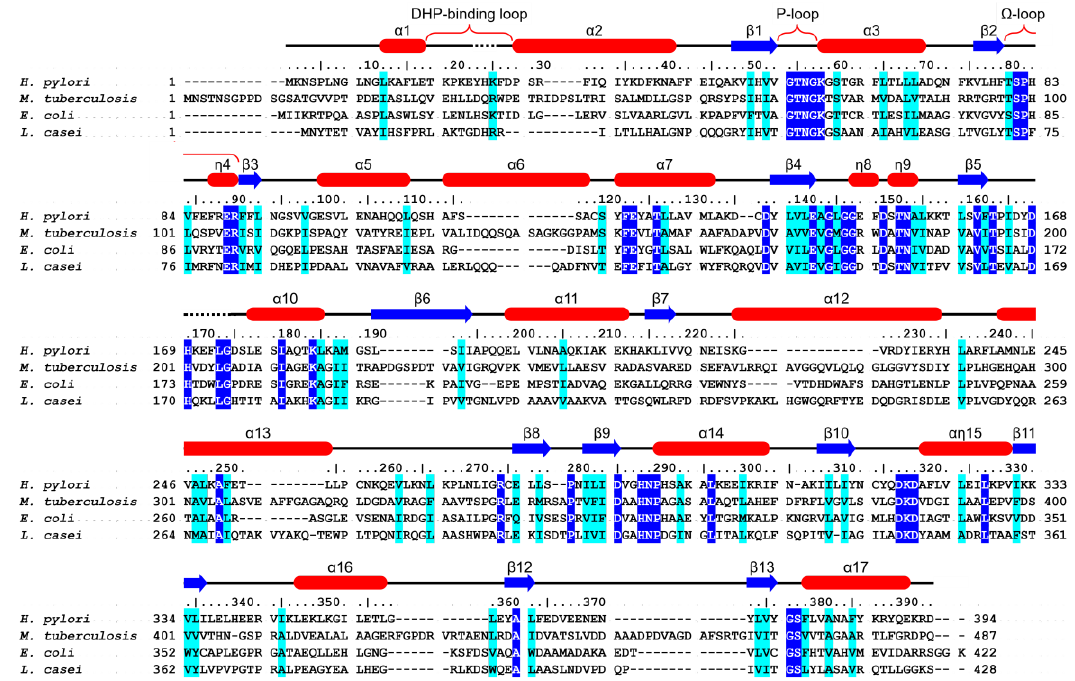
Figure 3. Sequence alignment of Hp FolC with structure-determined FolC / FPGSs. The FolC / FPGS sequences are from H . pylori , M . tuberculosis , Escherichia coli , and Lactobacillus casei . Identical and highly conserved residues are colored in blue and cyan, respectively. Secondary structures of Hp FolC are shown above its sequence.